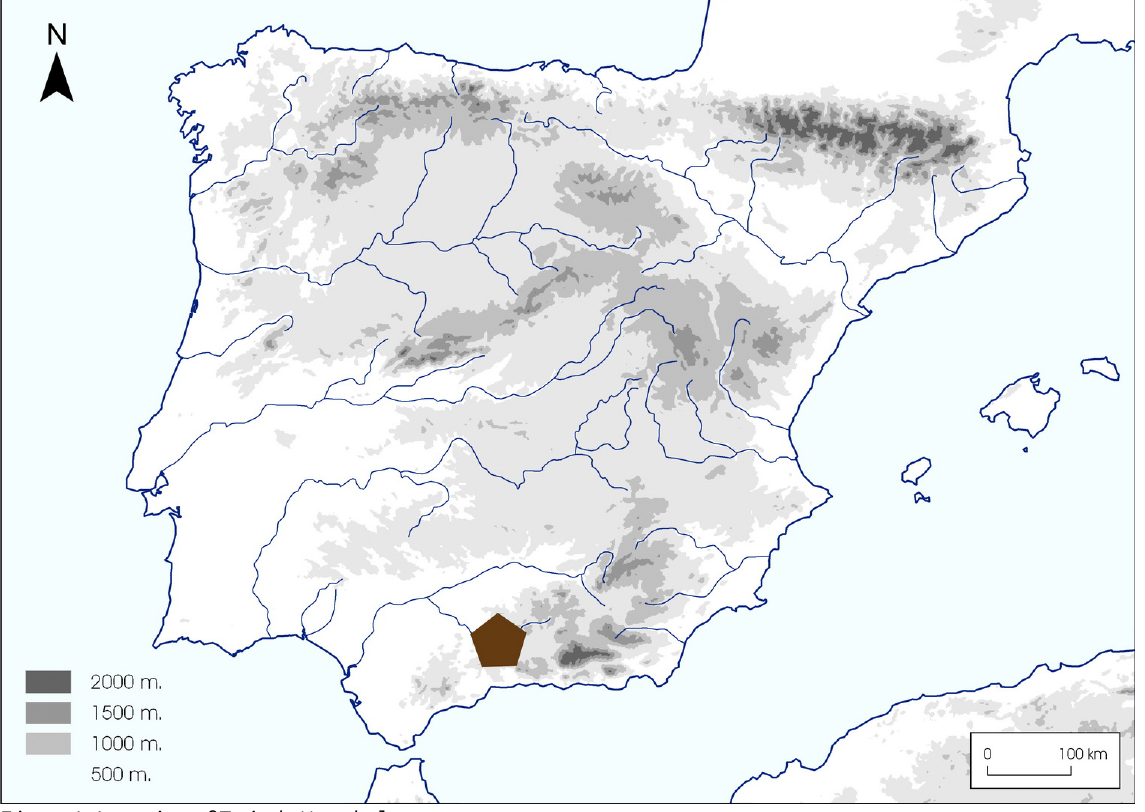
Figure 1. Location of Tajo de